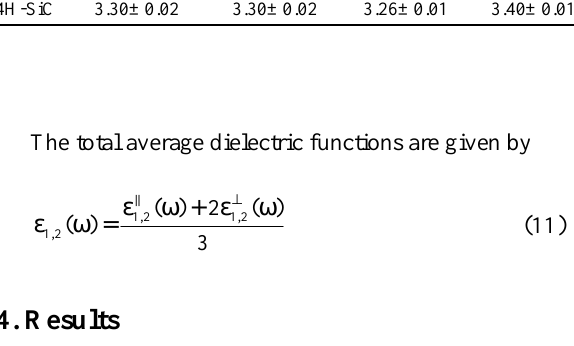
Figure 1. The total real part e tric functions.